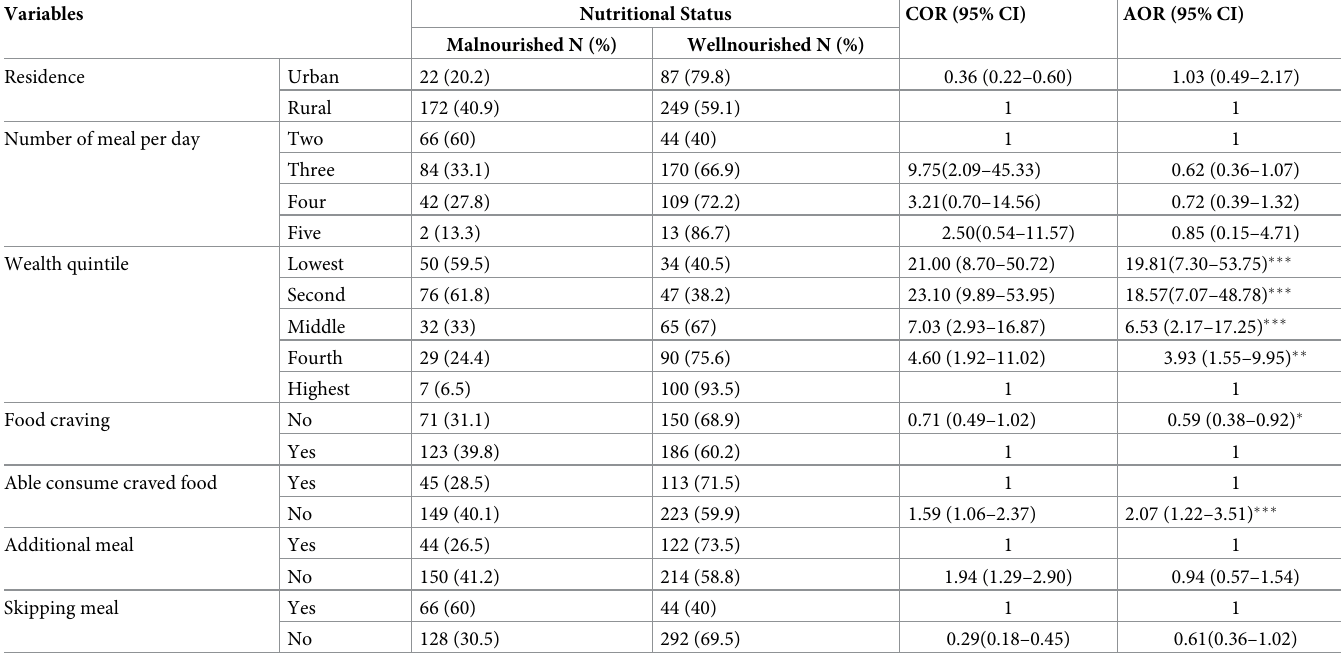
Table 5. Factors associated with nutritional status of pregnant women in Sidama Regional State, Southern Ethiopia, 2021.